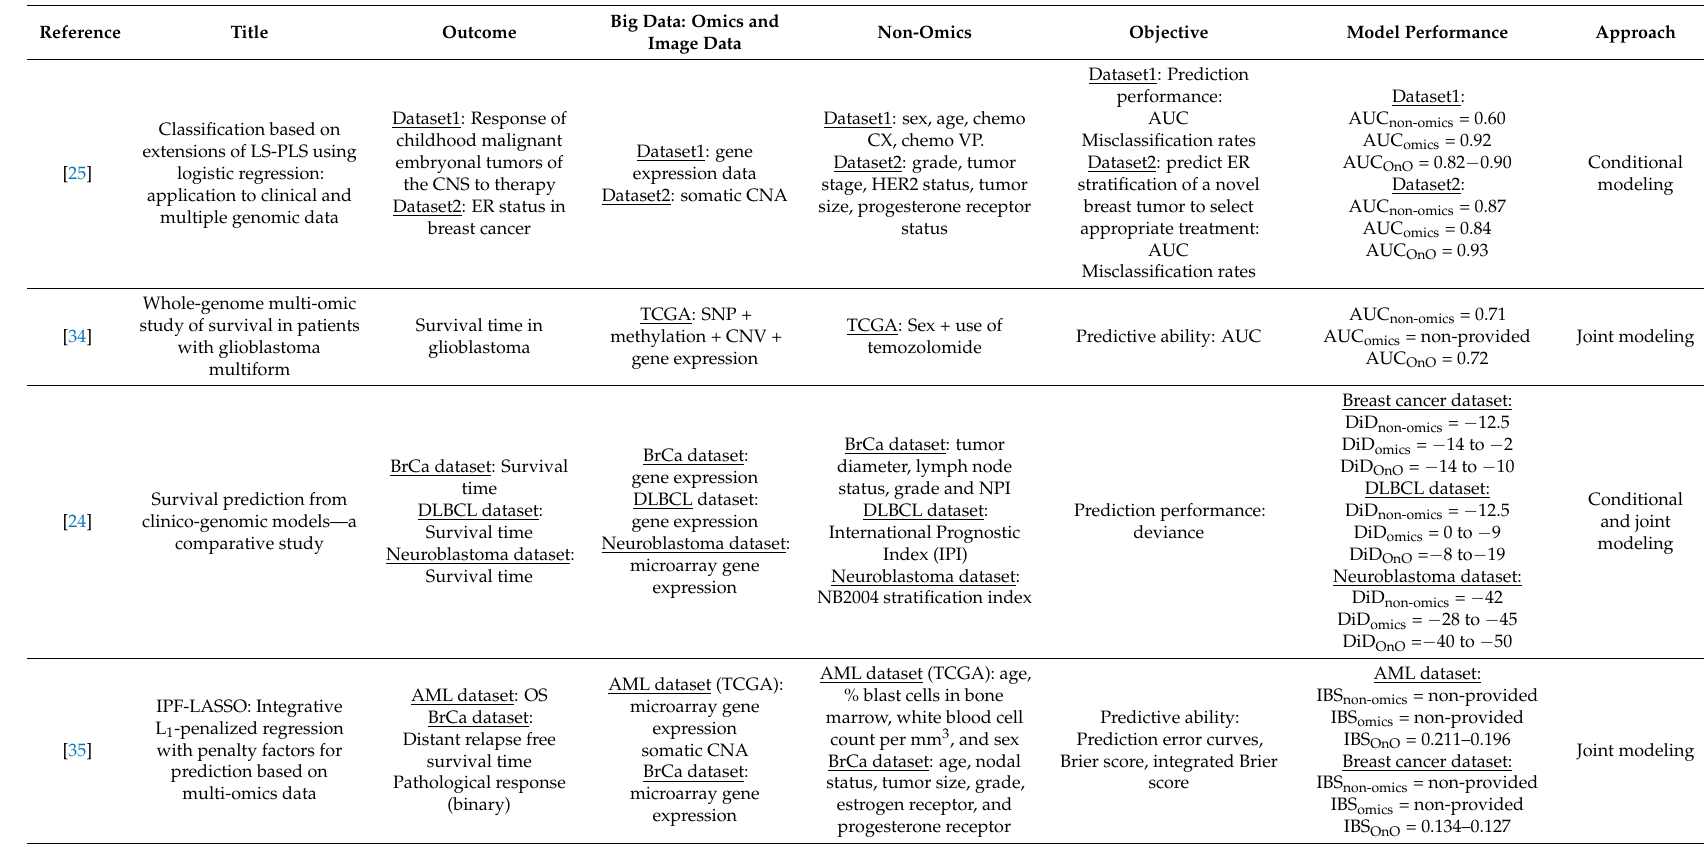
Table 1. Main features of the identified studies conducting omics and non-omics data